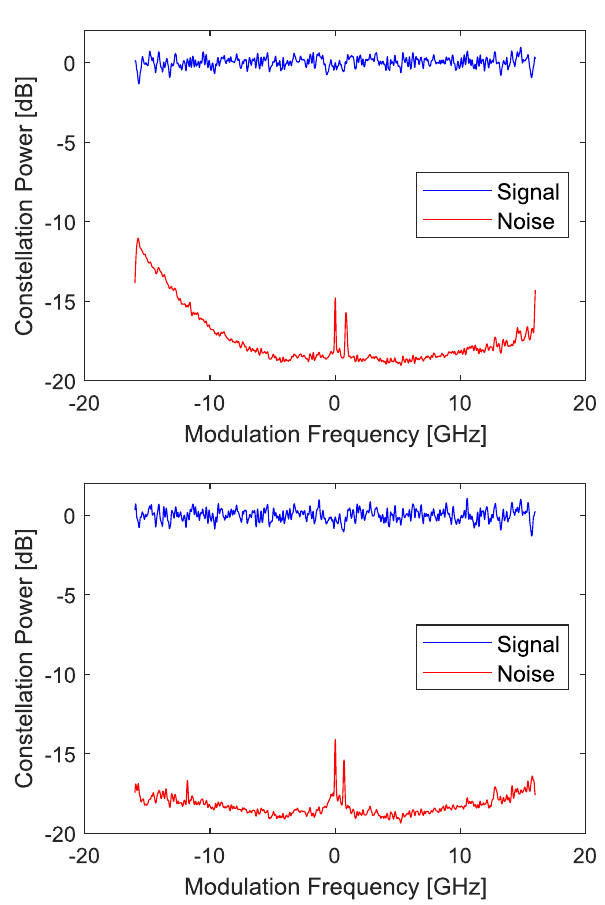
Figure 9. WSS interference. The spectrum of the signal and noise of the recovered constellation for the signal at 193.30 THz top and 193.45 THz